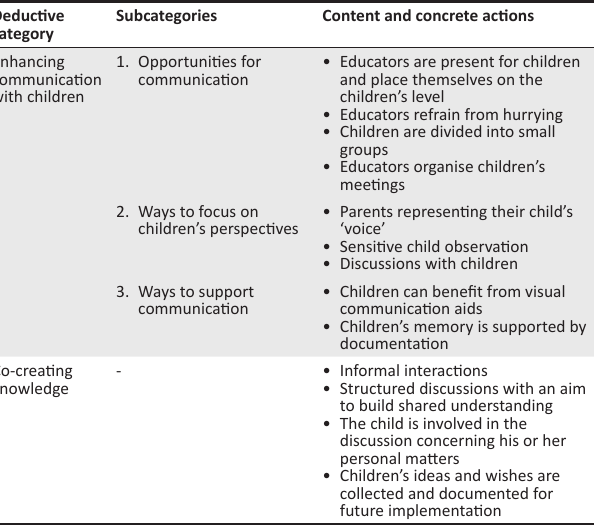
TABLE 2: Enhancing communication and access to knowledge as prerequisites for participation.